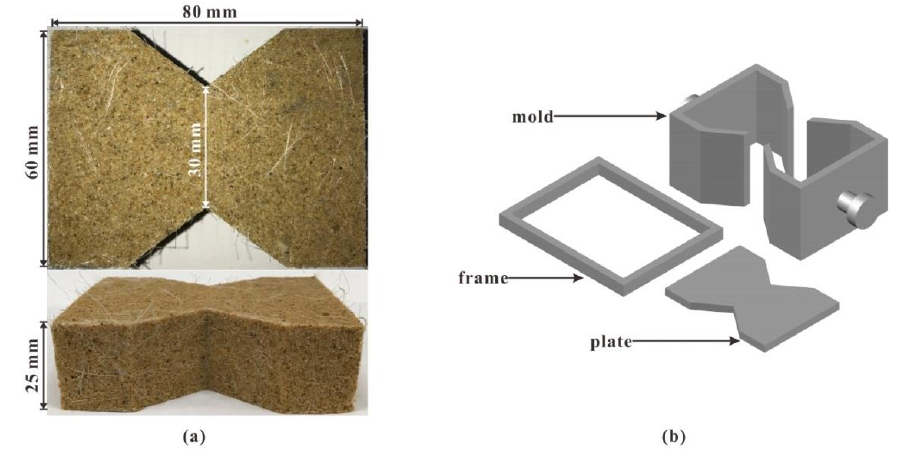
Figure 3. Schematic drawing of ( a ) prepared specimen and ( b ) mold and its components.